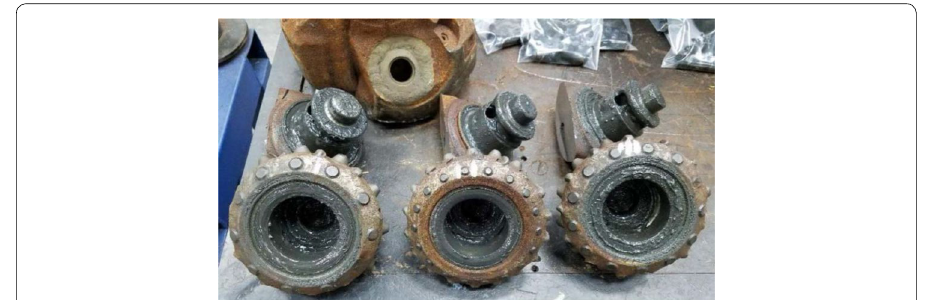
Fig. 6 Cones and bearing from high-temperature tri-cone roller cone drill bits used during drilling of the IDDP-2 well in the Reykjanes geothermal field in Iceland (Stefánsson et al.